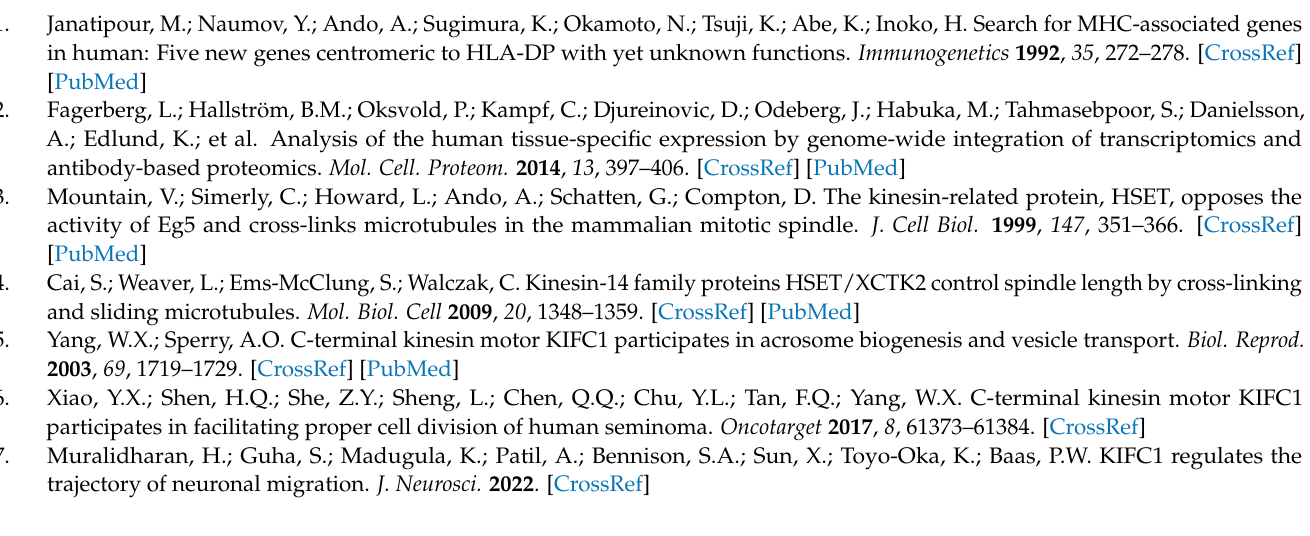
GEPIA2. Table S3. Raw data of correlation of ImmuneScore, StromalScore, and ESTIMATEScore with KIFC1 expression in tumors of TCGA